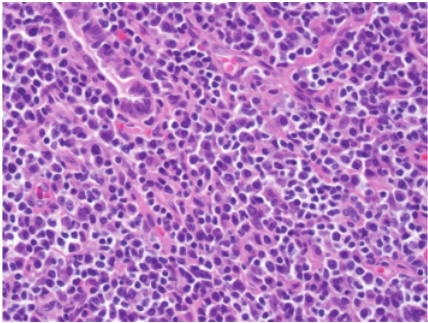
Figure 3: × 40 magnification of left lung nodularity at a germinal center. Note the appearance of lymphoplasmacytic infiltrates with reactive appearing plasma